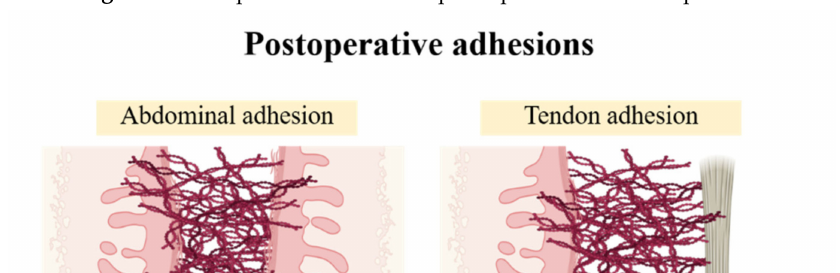
Figure 1. A simple schematic of the post-operative adhesion process.